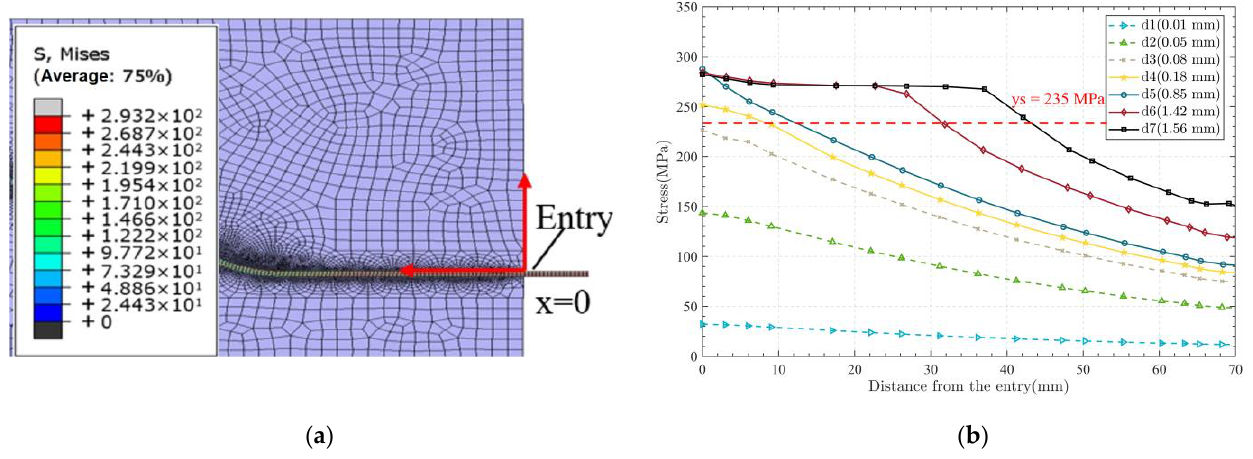
Figure 11. Steel wire Mise stress distribution; ( a ) Zero position; ( b ) Stress distribution at different Figure 11. SteelwireMisestressdistribution; ( a )Zeroposition; ( b displacement.